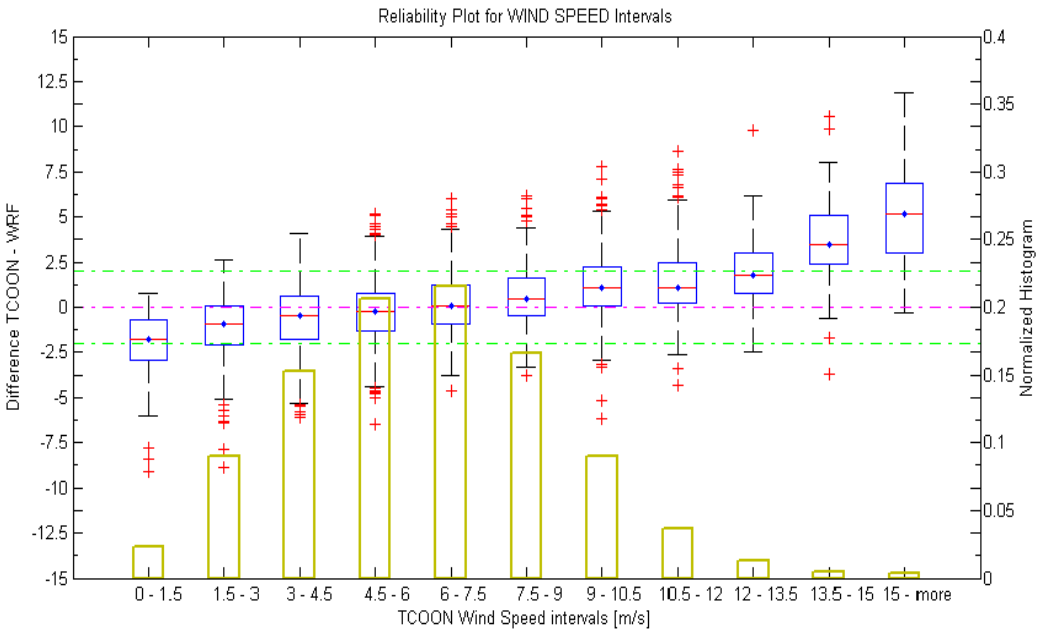
Figure 25. Boxplot showing the differences between measured and predicted wind speed values for the TCOON site “Bob Hall Pier” for different wind speed bin intervals. The measured (TCOON) wind speed histogram is shown for comparison.